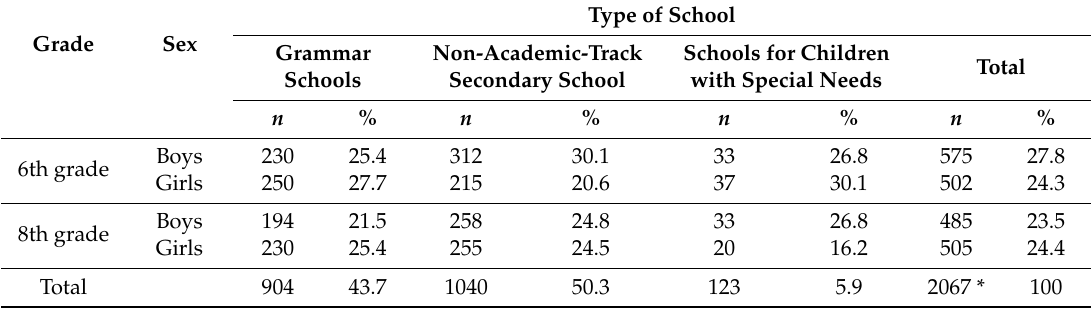
Table 1. Frequencies of demographic variables by grade, sex, and type of